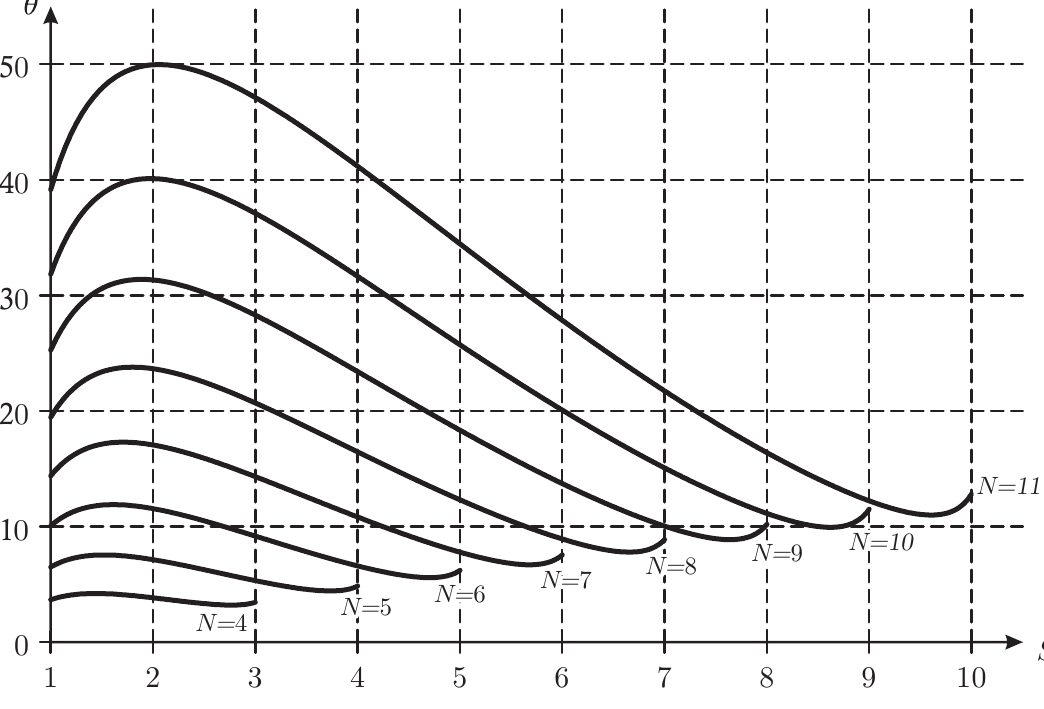
Figure 3. Stability analysis for N ∈ [4 , 12)